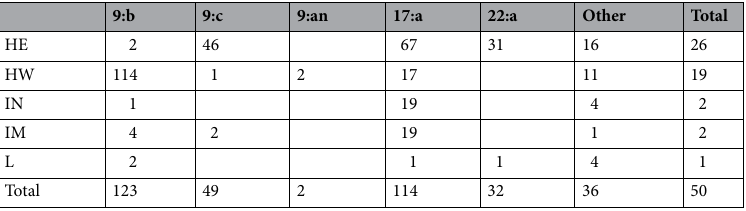
Table 1. The original incorrect version of the Table